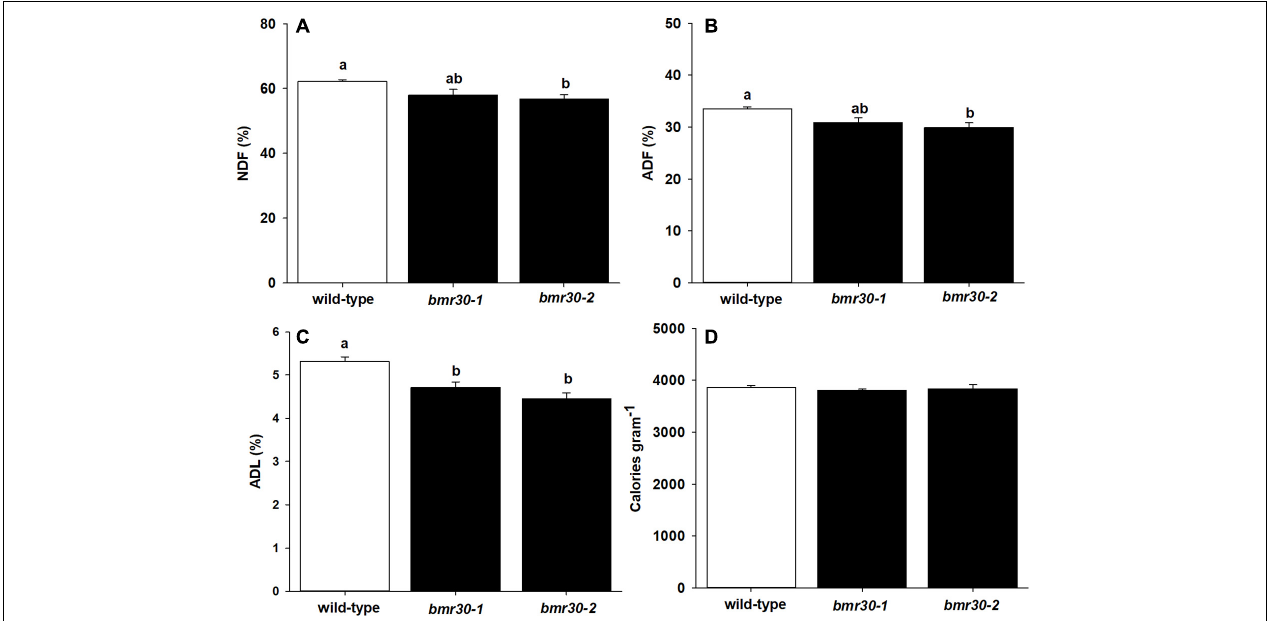
FIGURE 5 | Stover from mature wild-type (BTx623), bmr30-1 , and bmr30-2 plants was subjected to fiber analysis to determine percent of (A) neutral detergent fiber (NDF), (B) acid detergent fiber (ADF), and (C) acid detergent lignin (ADL). The NDF, ADF, and ADL were determined using ANKOM fiber analyzer. Stover was also subjected to (D) bomb calorimetry to determine total energy using a Parr 6400 bomb calorimeter. Values presented are least squares means ( ± 1 SE). Samples with different letters are statistically different from one another at α ≤ 0.05 using Tukey’s HSD